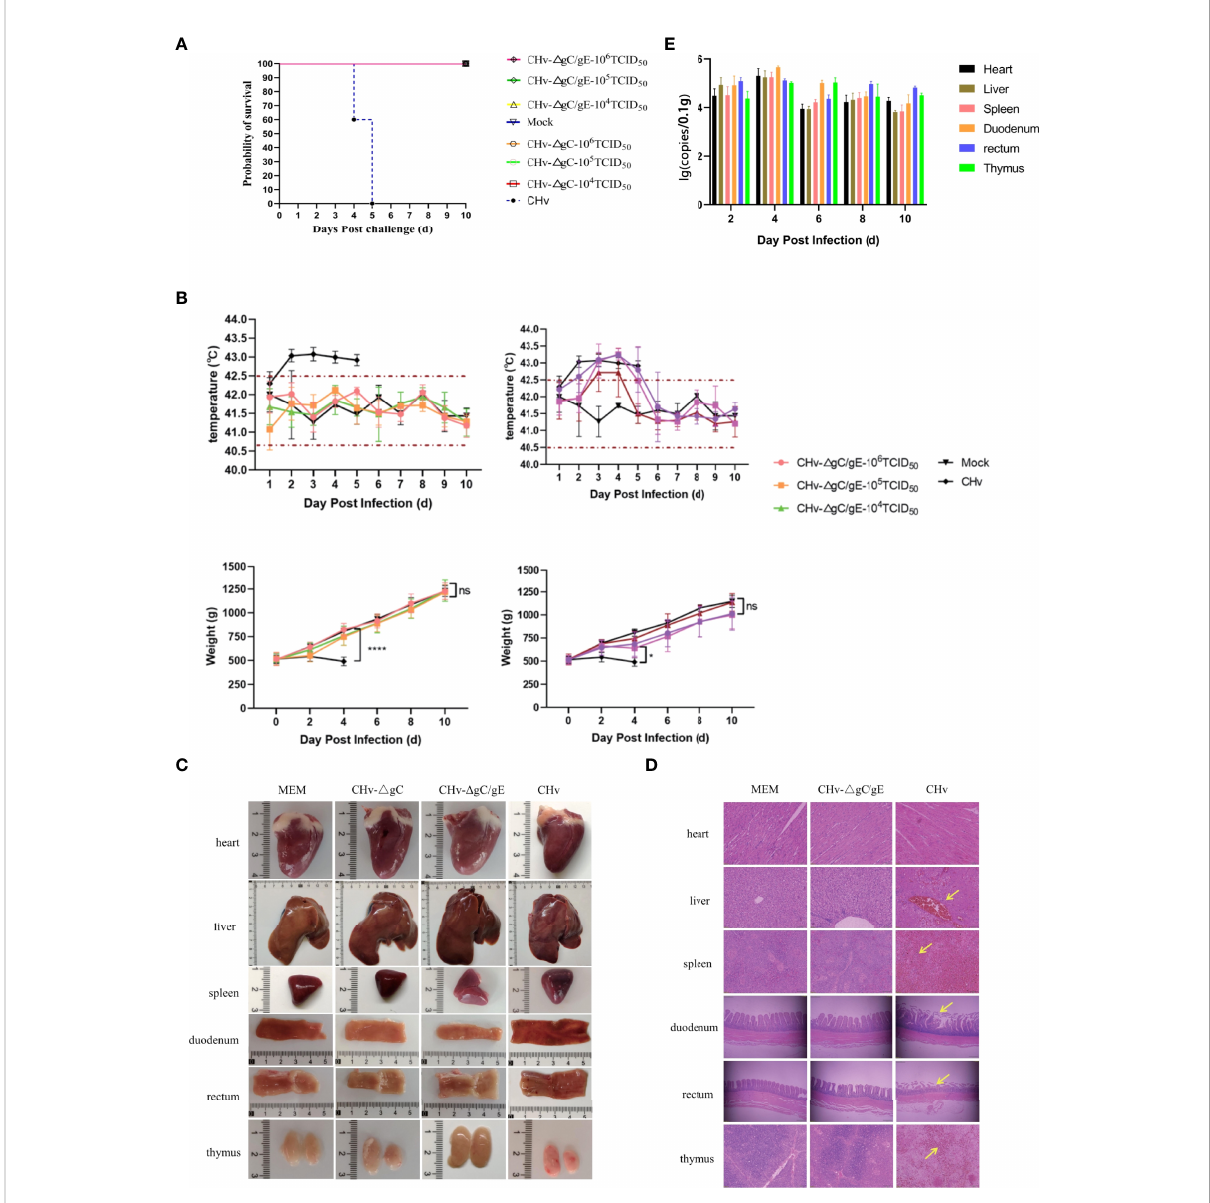
FIGURE 4 Pathogenicity of CHv- D gC/gE in ducklings. (A) Survival curves of ducklings after challenge with the indicated viral strains. (B) Daily body weight and temperature of all the ducklings after challenge with the indicated viral strains. (C) Postmortem examination of ducklings in each group at 5 dpi. (D) Histological analysis of heart, liver, spleen, duodenum, rectum and thymus from ducks injected with the indicated viral strains or MEM. Arrows indicate cellular in fi ltration or tissue disruption. (hematoxylin and eosin staining, 100× magni fi cation). (E) Quanti fi cation of viral DNA loads in selected tissues with real-time PCR. Viral DNA copy numbers were determined with primers speci fi c for UL30, as described above. *p<0.05; **p<0.01; ***p<0.001; ****p<0.0001; and ns, not signi fi